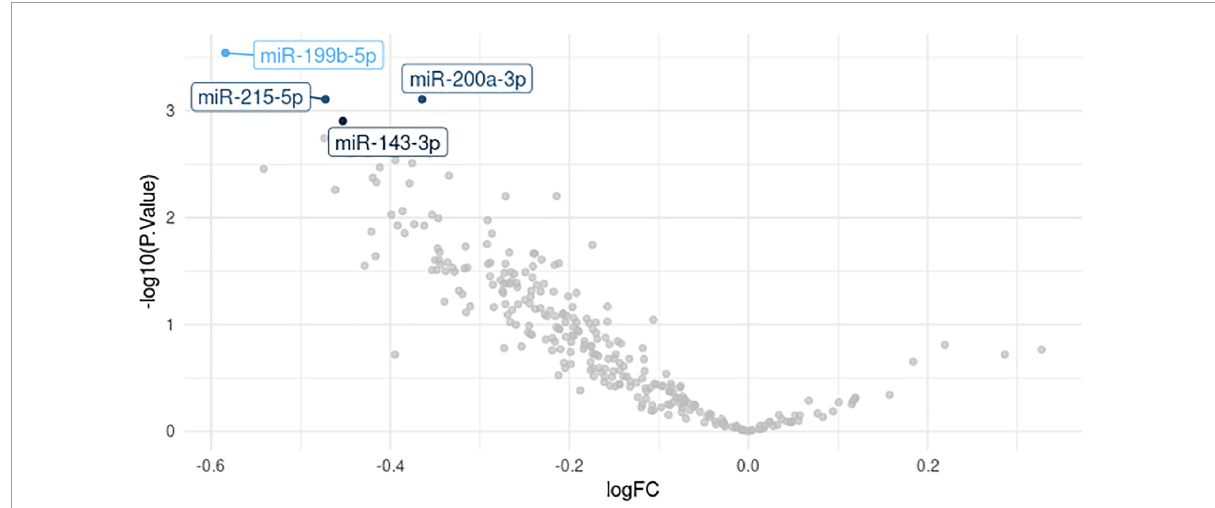
FIGURE1 Volcano plot. logFC for relapser vs. non-relapser was plotted against -logP, where P is the association p -value.